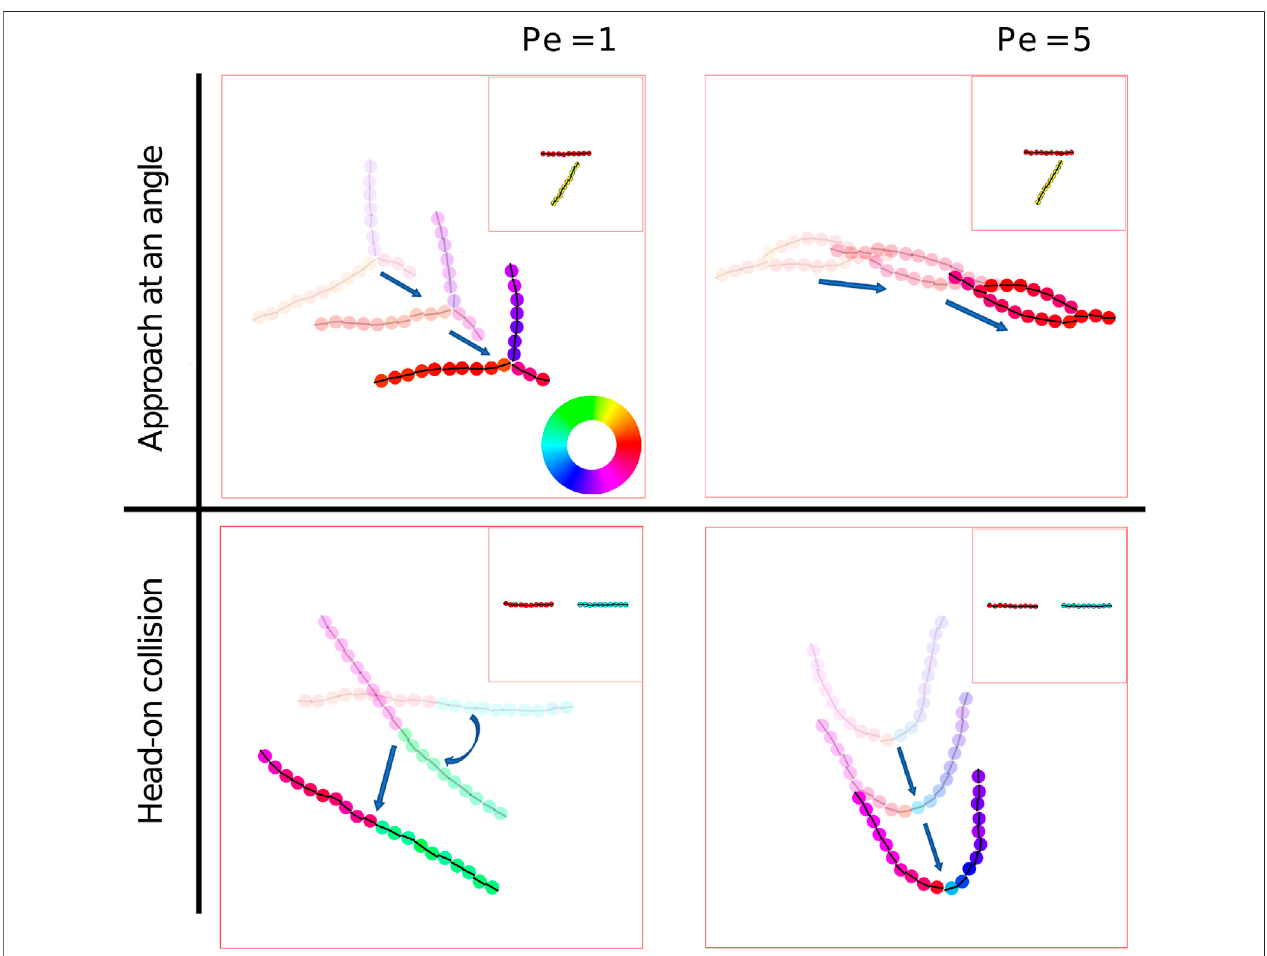
FIGURE8| Interactionoftwomotilechains(SupplementaryMovie( SupplementaryMovieS8 ).Twostraightchainsof10particleseachareinitializedtoapproach each other at an angle of π and also π ( “ head-on ” ) at Pe = 1 and 5. At Pe = 1, a “ Y ” junction forms for an approach angle of π 3 occurs.Uponhead-oncollision,alonger fl uctuatingchainwithnegligiblenetmotilityresultsat Pe =1,andapropelling,buckledshapeisobservedat Pe =5.Insetsatthe top corners represent the approach of the chains. Color represents angle of orientation of particles. The arrows indicate progression in time and suggest that the con fi gurations are both stable and